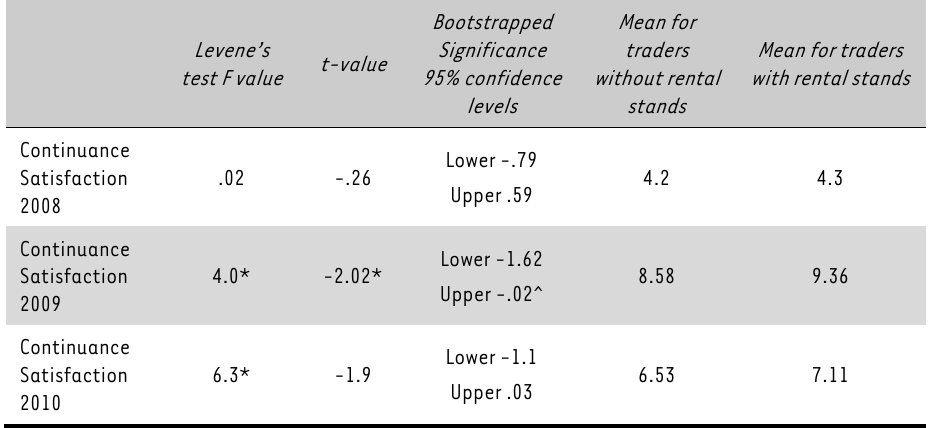
TABLE A4: Results of the t-tests for differences in Continuance Satisfaction